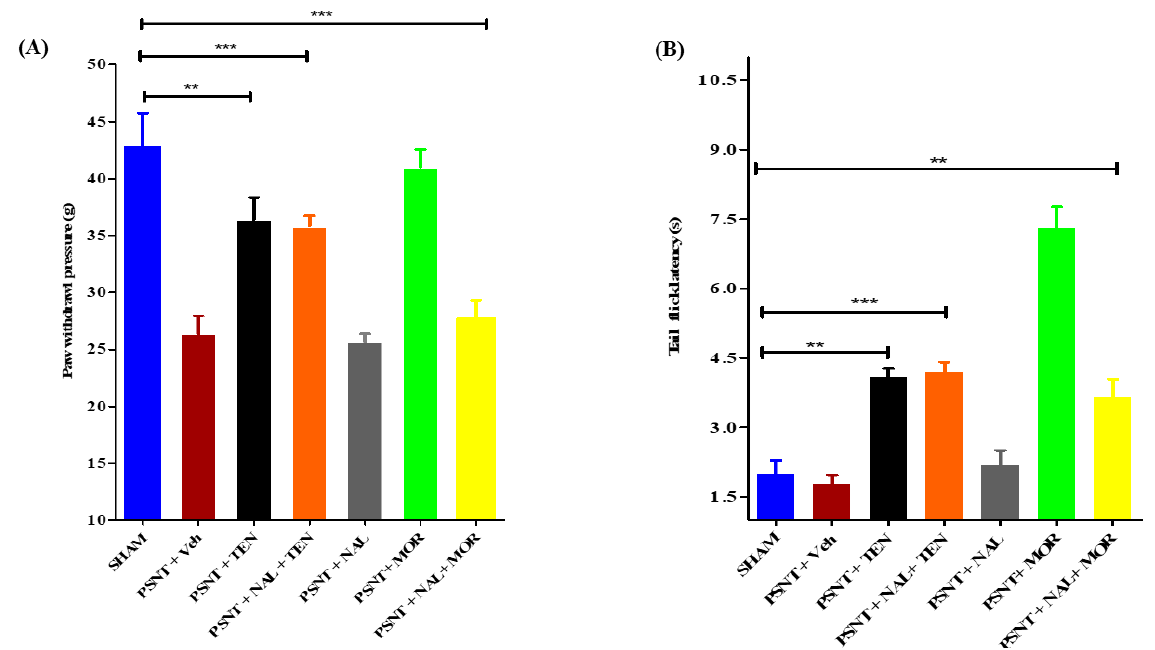
Figure 2. Effect of naloxone pre-treatment on TEN’s antinociceptive effects in PSNT rats. The effect of intrathecal opioid antagonist pretreatment on ( A ) Mechanical allodynia and ( B ) tail-flick latency are evaluated by administering a single i.t injection of naloxone (10 µ g) 15 min before the i.t injection of TEN (5 µ g/5 µ L) or MOR (5 µ g/5 µ L). The effects of antinociception are compared with the sham group and the rats treated with a single i.t injection of vehicle (5 µ L) or naloxone (10 µg/5 µL) or TEN (5 µg/5 µL) or MOR (5 µg/5 µL) in PSNT rats. * denotes a statistically significant difference between sham vs. PSNT + TEN, sham vs. PSNT + NAL + TEN and sham vs. PSNT + NAL + MOR. ** p < 0.01; *** p < 0.001, ( n = 6 animals per group).